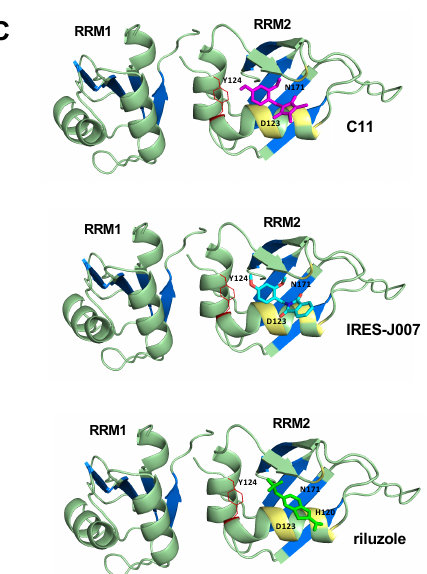
Figure 1. Riluzole is an hnRNP A1 inhibitor identified via in silico molecular docking analyses. ( A ) Chemical structures of hnRNP A1 inhibitors. ( B ) Interaction properties of compounds C11, IRES-J007 and riluzole. Critical residues of hnRNP A1 for inhibitor binding are listed. ( C ) Conformers of C11 (magenta), IRES-J007 (cyan) and riluzole (chartreuse) with the lowest binding free